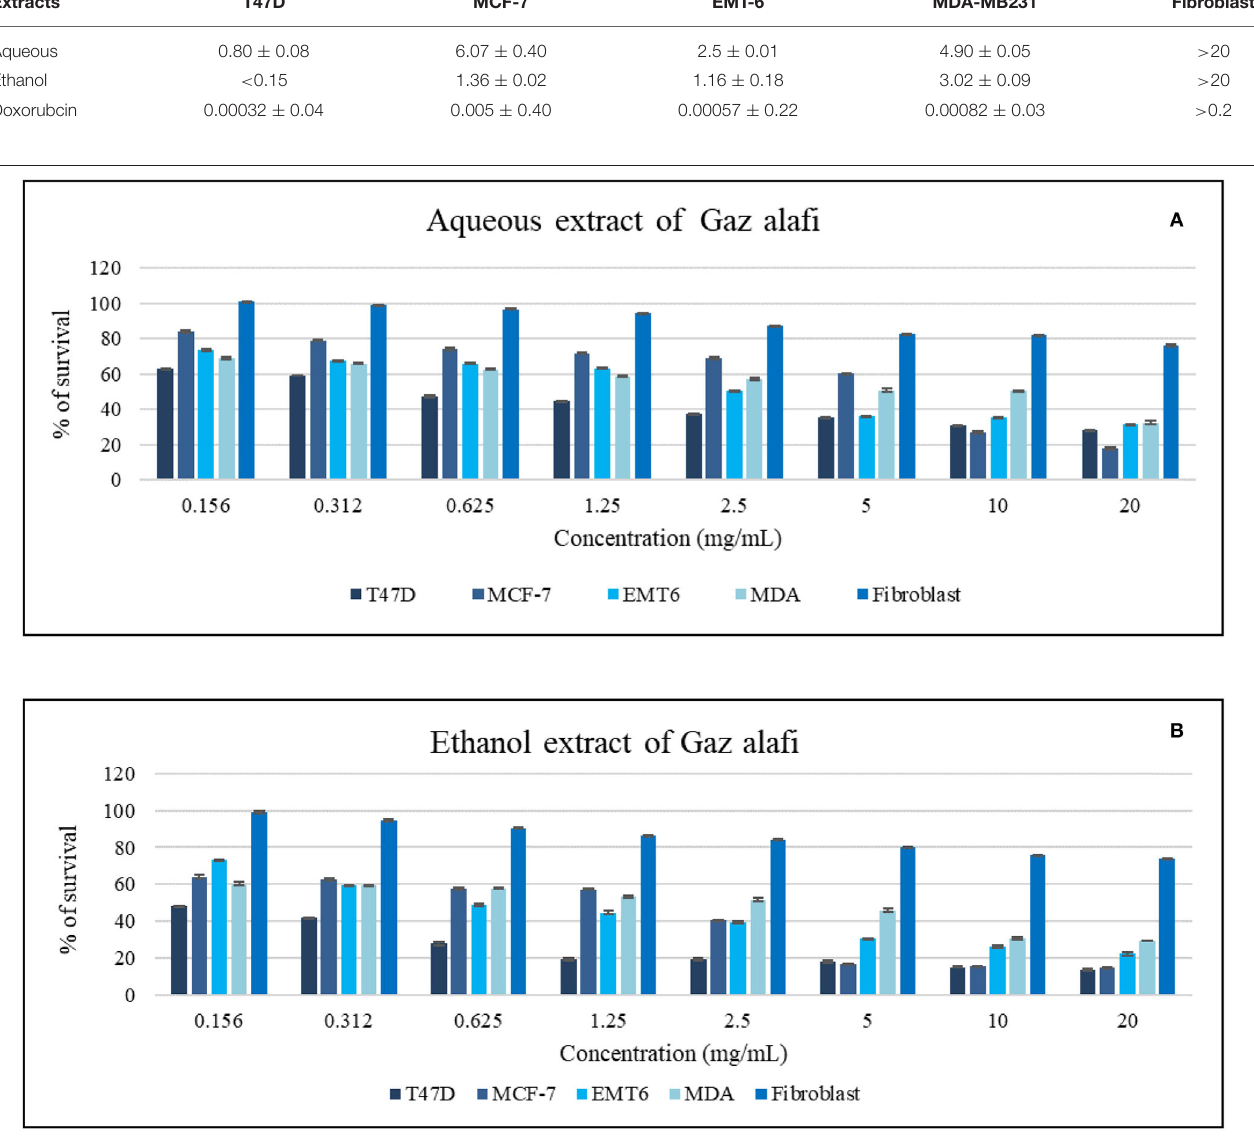
TABLE 3 | The effects of Gaz alafi extracts on the proliferation of breast cancer cell lines and Fibroblast normal cell line represented as IC 50 (mg/ml) as mean ± SEM, n = 3.